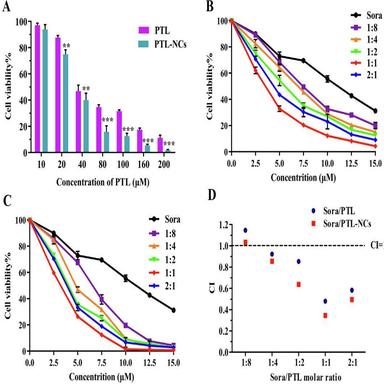
(A) The in vitro antiproliferation activity of PTL and PTL-NCs, variable molar ratios of Sora to (B) PTL and (C) PTL-NCs in HepG2 cells after incubation for 24 h. (D) The CI value of Sora and PTL combinations at different molar ratios. Data are presented as mean ± SD (n = 6). \ means p < 0.05, \\ means p < 0.01 and \\\ means p < 0.001.